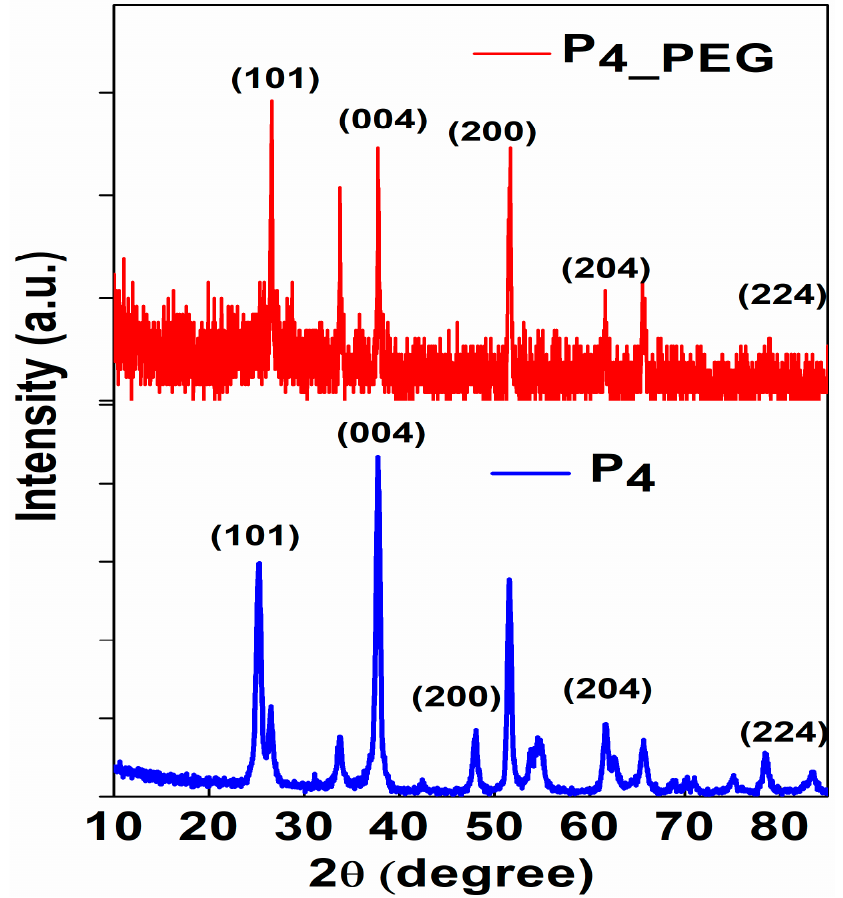
Figure 6. The X-ray di ff raction (XRD) pa tt erns of P 4 and P 4_PEG thin fi lms dip-coated on FTO substrate.